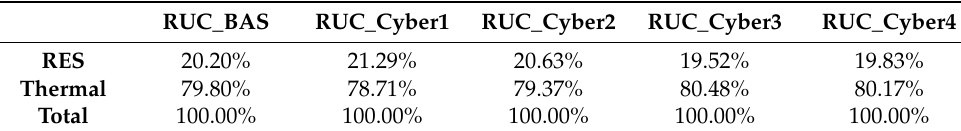
Figure 6. Evolution of hourly energy mix of the examined typical day for the RUC_BAS scenario. 413